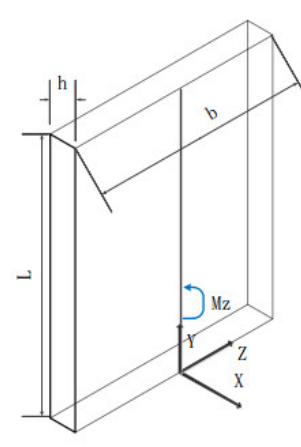
Figure 4. Bending moment diagram.